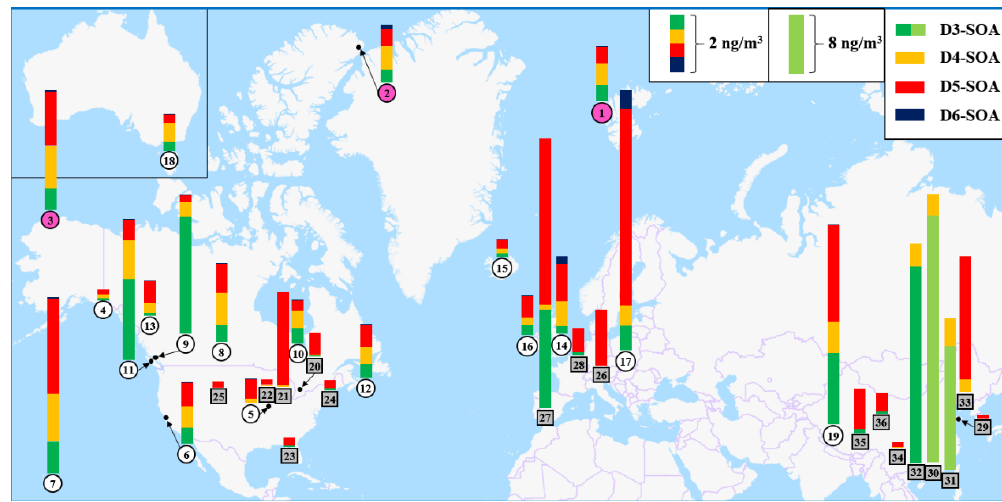
Figure 4. Global concentrations of cVMS SOAs (ngm − 3 ) on the basis of the cVMS concentrations reported in multiple studies and the cVMS SOA yields measured in this work. The numbers of polar, background and urban sites are enclosed in pink, white circles and gray boxes, respectively. The details about cVMS and SOA concentrations at different sites are summarized in Table S6 in the